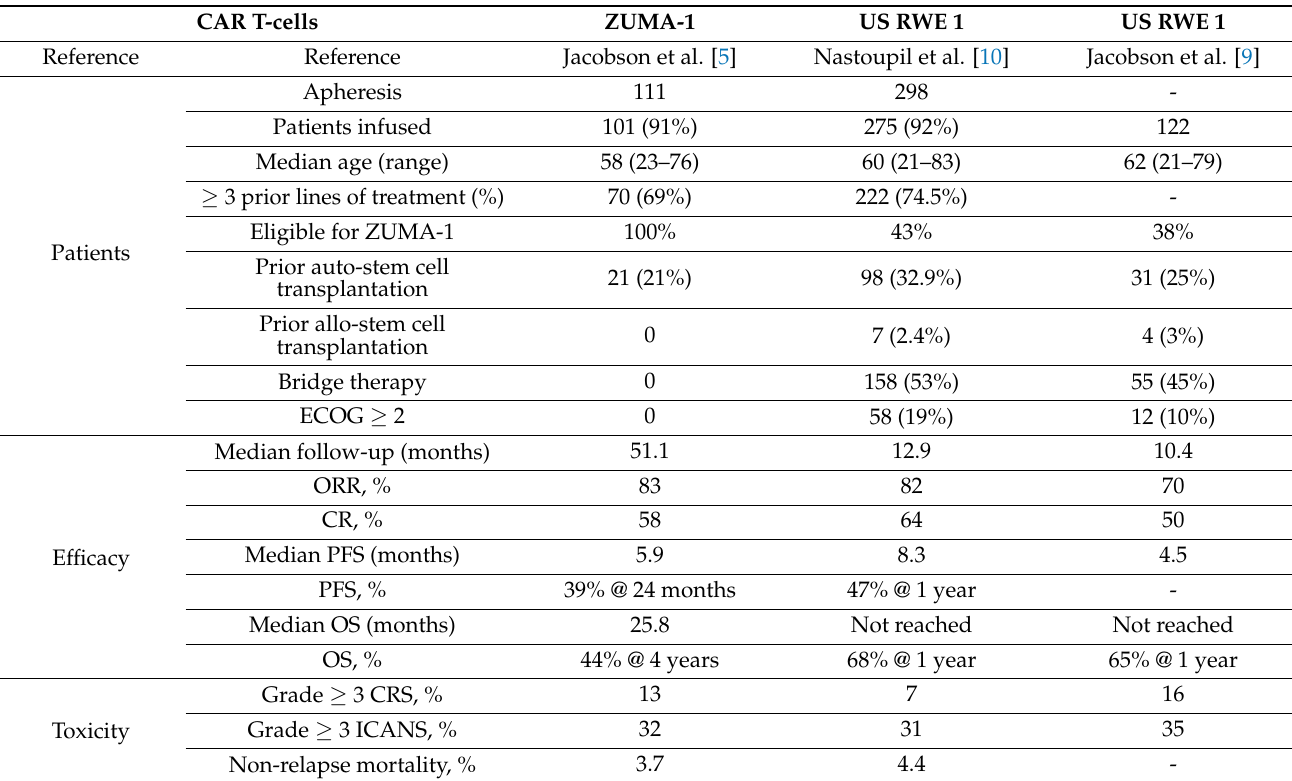
Table 3. Axi-cel (Yescarta ® ): ZUMA-1 vs. Real-world Experience.